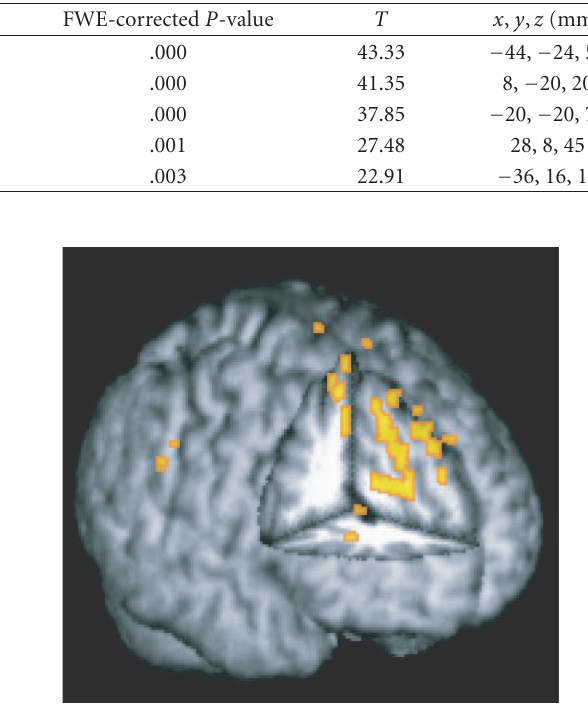
Figure 5: Contiguous clusters in right frontal cortex where the slope is − 1. Several clusters were identified in the secondary analysis to assess for areas where activity was opposite in younger and older adults. These areas within right frontal cortex tended to be active across tasks in younger adults and deactivated across task in older adults. Further, these areas correspond to regions involved in atten- tion and task decisions, which have also been implicated in general cognitive slowing